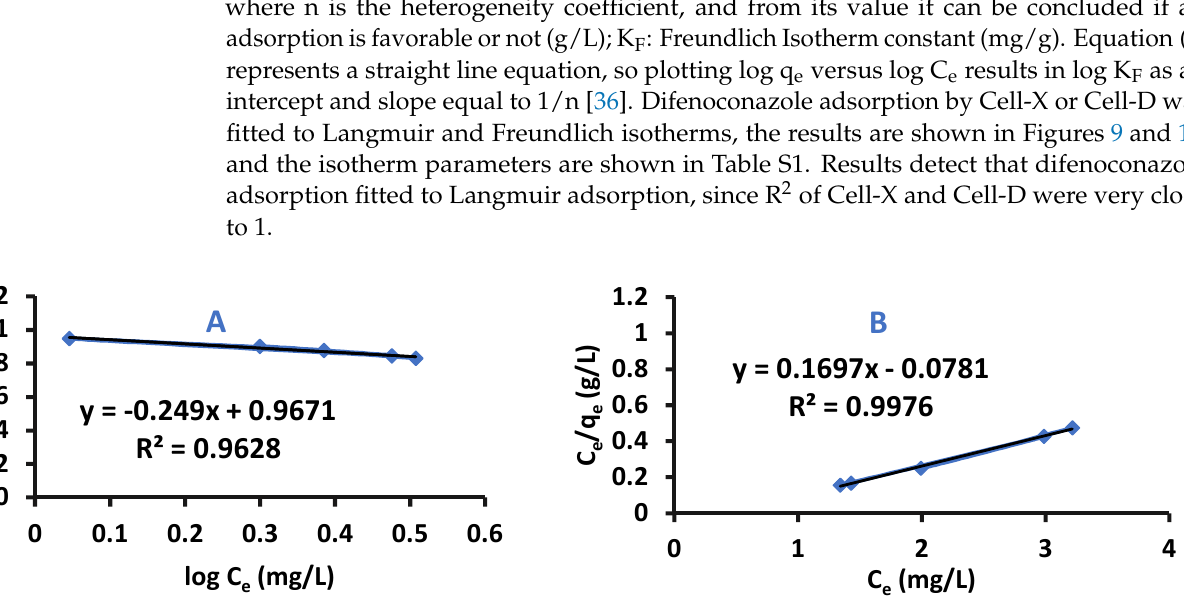
Figure 10. ( A ) Freundlich ( B ) Langmuir plots for difenoconazole by Cell-X (pH: 6, volume: 10 mL, temperature: 20 °C, adsorption time: 20 min, dosage: 10 mg). The values of R 2 obtained by Langmuir isotherm were close to 1, an indication of the high affinity for Cell-X and Cell- D of difenoconazole, and the adsorption process follows the Langmuir isotherm model. 2.3.3. Adsorption Kinetic Models Kinetic models can be used to determine the adsorption mechanism of removal of adsorbate by adsorbent, and whether the adsorption process is chemically or physically controlled. The adsorption kinetic models that are evaluated in this work were pseudo- first-order, pseudo-second-order and Intra–Particle–Diffusion-Kinetics [37–39]. Pseudo–First-Order–Kinetics The Pseudo-First-Order equation is presented below log ( q (cid:2915) − q (cid:2930) ) = logq (cid:2915) − K (cid:2869) 2.303 t